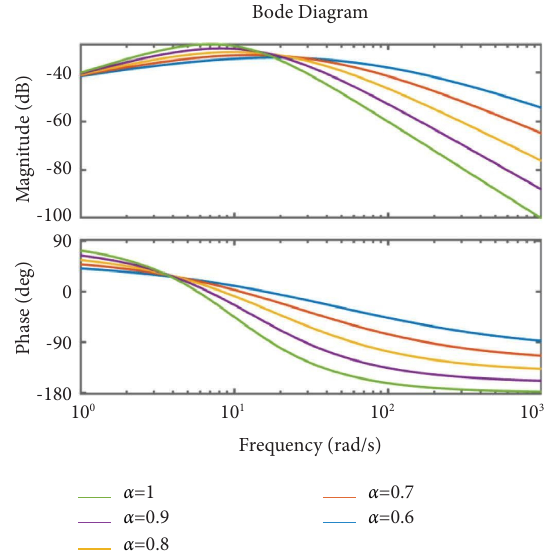
Figure 10: Te frequency-domain characteristic of FOESO ob- servation noise (observer order α ).